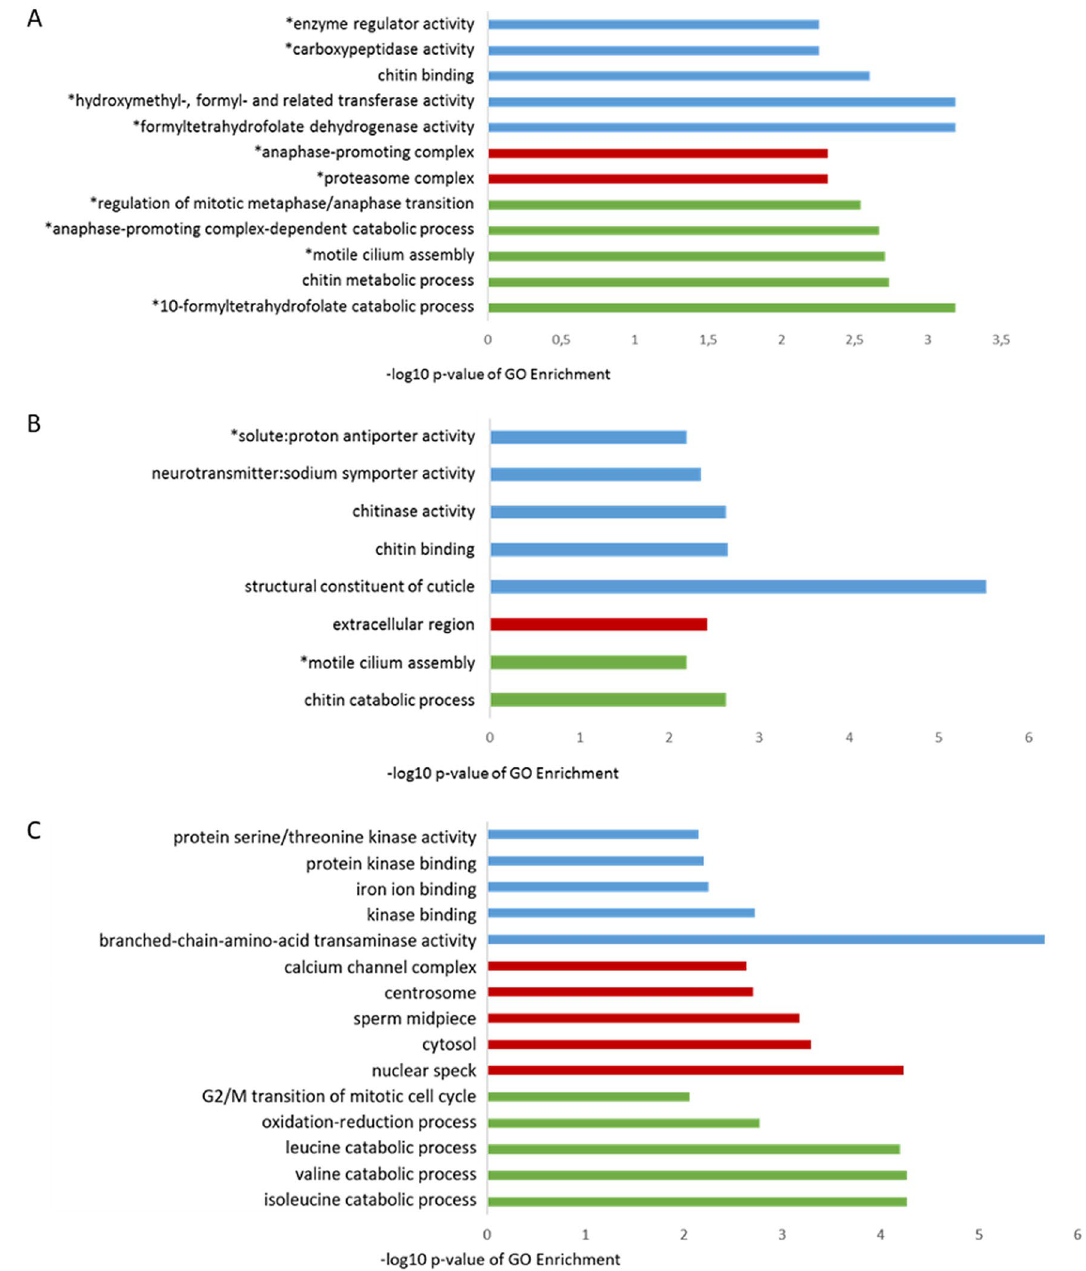
Figure 4. Enriched top five or all significantly overrepresented GO terms of differentially expressed genes of A. mellifera ( A ) workers and ( B ) larvae and ( C ) Varroa treated with FA (24 hpt). Molecular functions are shown in blue, cellular components are shown in red and biological processes are shown in green. GO terms marked with stars indicate that only one gene is accumulated in each of these from the CYP4 family ( CYP4G11, CYP4AV1 , and CYP4AZ1 ). Thus, in the RT-qPCR experiments a total of seven honey bee candidates were investigated. In order to compare the detoxification mechanisms and the different sensitivity of workers and larvae to FA, all candidate genes were equally examined among both age groups. It should be noted that not all of the candidate genes analysed in the RNA-Seq results were differentially regulated in both age groups. A significant induction (fold change (FC) ≥ 2, p-value: ≤ 0.05) of the detoxification-associated gene CYP6AR1 (FC = 3.2, U = 238, Z = − 3.083, p = 0.002) was observed in workers. In the larval group a significant repression of CYP4G11 (FC = 0.5. U = 170, Z = − 4.698, p < 0.001) was observed 24 hpt (Fig. 5). For some candidate genes, we observed significant regulation but below our initial threshold of a two-fold difference. In the group of workers, these included the repressed gene CYP4AV1 (by FC = 0.6) and the upregulated FDH (by FC = 1.4). In the group